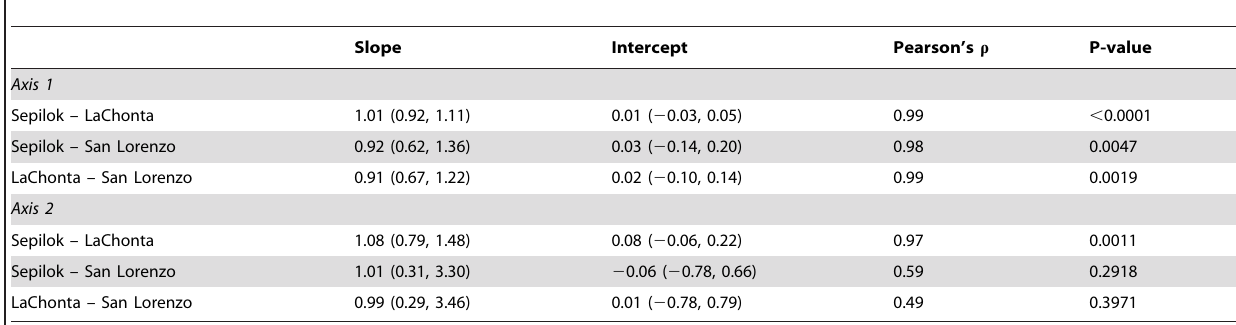
Table 2. Pearson’s correlation and regression coefficients (lower CI, upper CI) for pairwise relationships between principal components loadings at the three